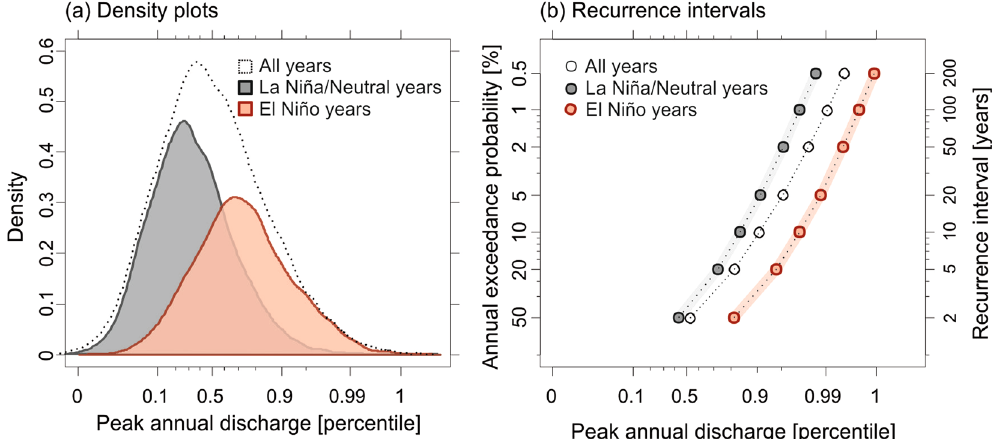
Figure 2. Left panel: Density plots of simulated peak annual discharge (log-transformed) for the lower Mississippi River in all years (dotted line, n = 11,550), La Niña/ENSO-Neutral years (grey, n = 9,191), and El Niño years (red, n = 2,359). Right panel: Recurrence intervals and annual exceedance probabilities in relation to peak annual discharge for all years (dotted line), La Niña/ENSO-Neutral years (grey points), and El Niño years (red points); uncertainties at the 95% confidence level are smaller than the size of the points. Peak annual discharge is plotted as a percentile of all simulated peak annual